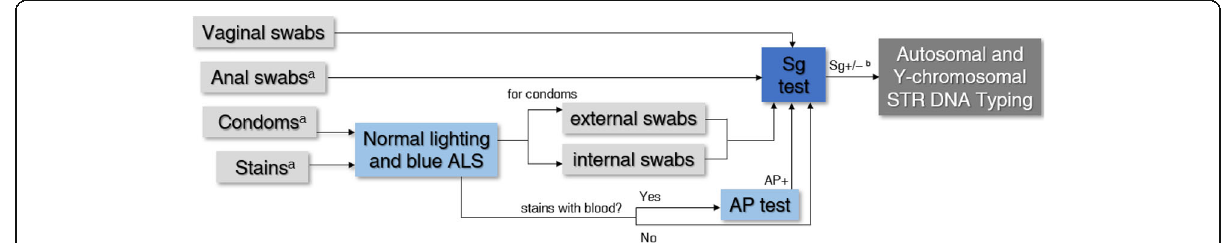
Fig. 4 A proposed workflow for semen detection in sexual assault samples. Light and dark blue shapes indicate presumptive and confirmatory tests, respectively. Superscript a indicates samples with fecal material should be processed immediately or otherwise kept in cold storage. Superscript b indicates if multiple samples from a case were tested, and only those with the strongest positive signals may proceed